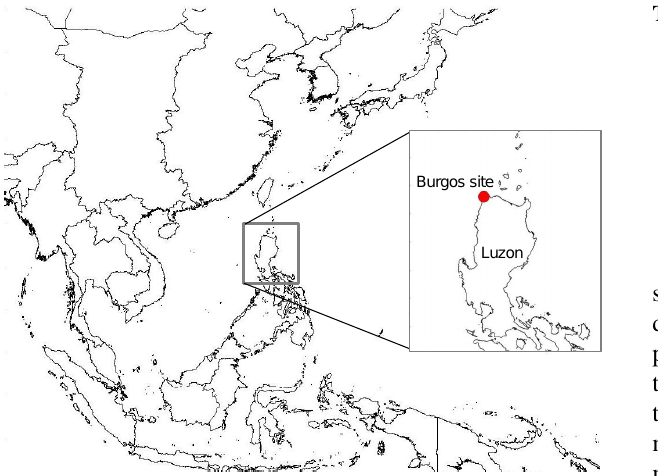
Figure 1. Map of East Asia, Southeast Asia and sampling site in Burgos,